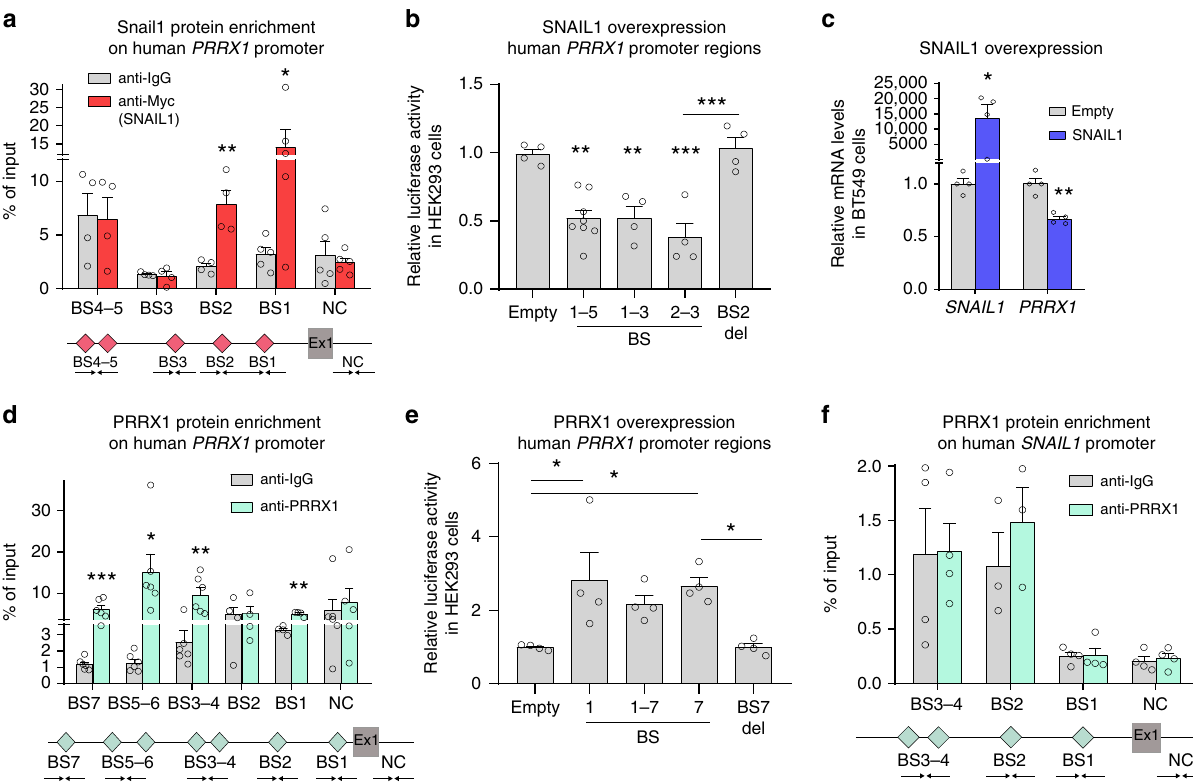
Fig. 2 SNAIL1 and PRRX1 act antagonistically on PRRX1 promoter. a Snail1 enrichment in the human PRRX1 promoter shown by ChIP assay in BT549